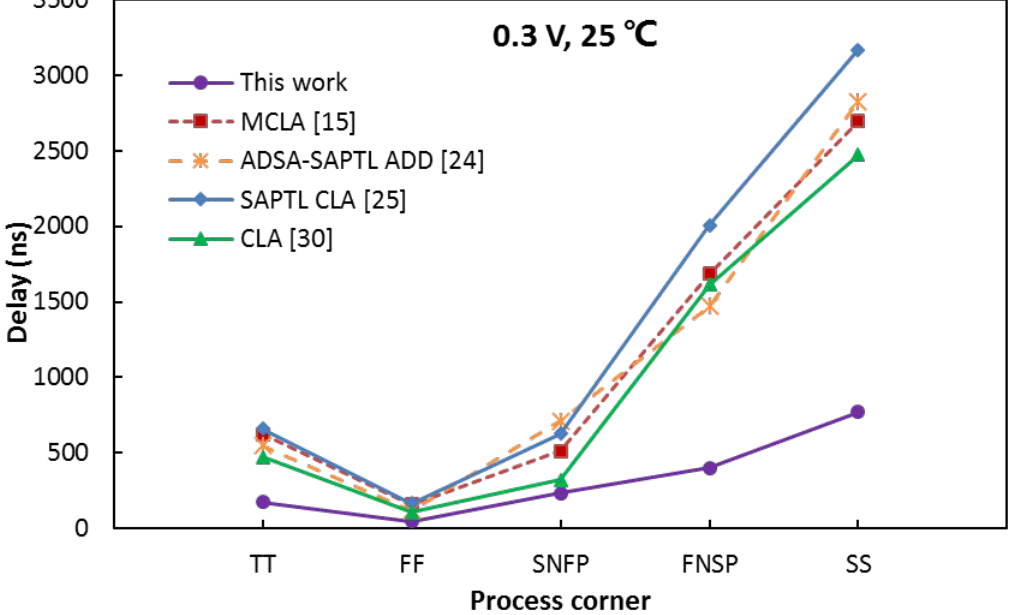
Figure 12. The worst-case delays at all process corners at 0.3 V.